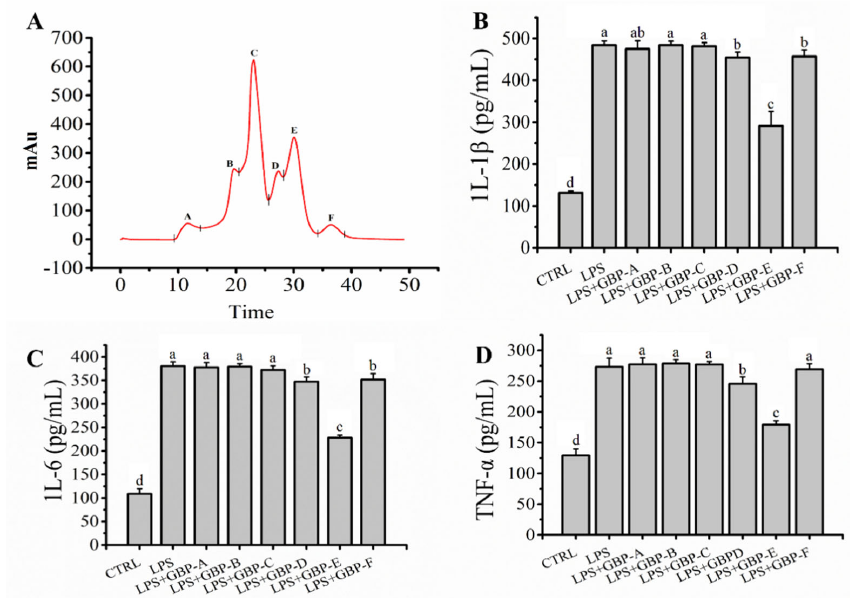
Figure 2. ( A ) GBP was separated to different fractions by SEC; ( B – D ): Effects of GBP − (A–F) pre- treatment (200 μ g/mL) on levels of IL − 1 β , IL − 6 and TNF −α on model of LPS ‐ mediated RAW264.7 macrophages damage. Different letters (a, b, c and d) in the figure represent significant differences between groups ( p < 0.05).